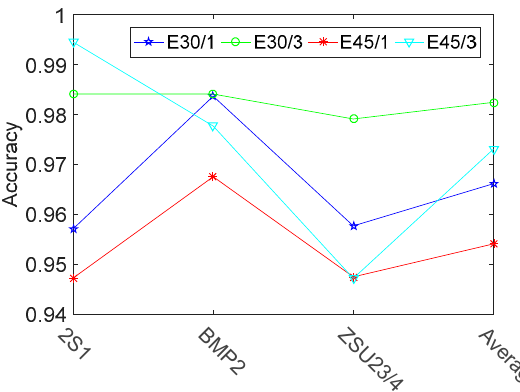
Figure 11. Recognition rates of three vehicles with different learning methods. The term ‘E30/1’ (‘E45/1’) denotes that each of the three modes is individually learned at an operating condition of a 17° depression and tested at an operating condition of 30° (45°) depression. Similar to the terms ‘E30/1’ and ‘E45/1’, the term ‘E30/3’ (‘E45/3’) denotes that all of the three modes are jointly learned.